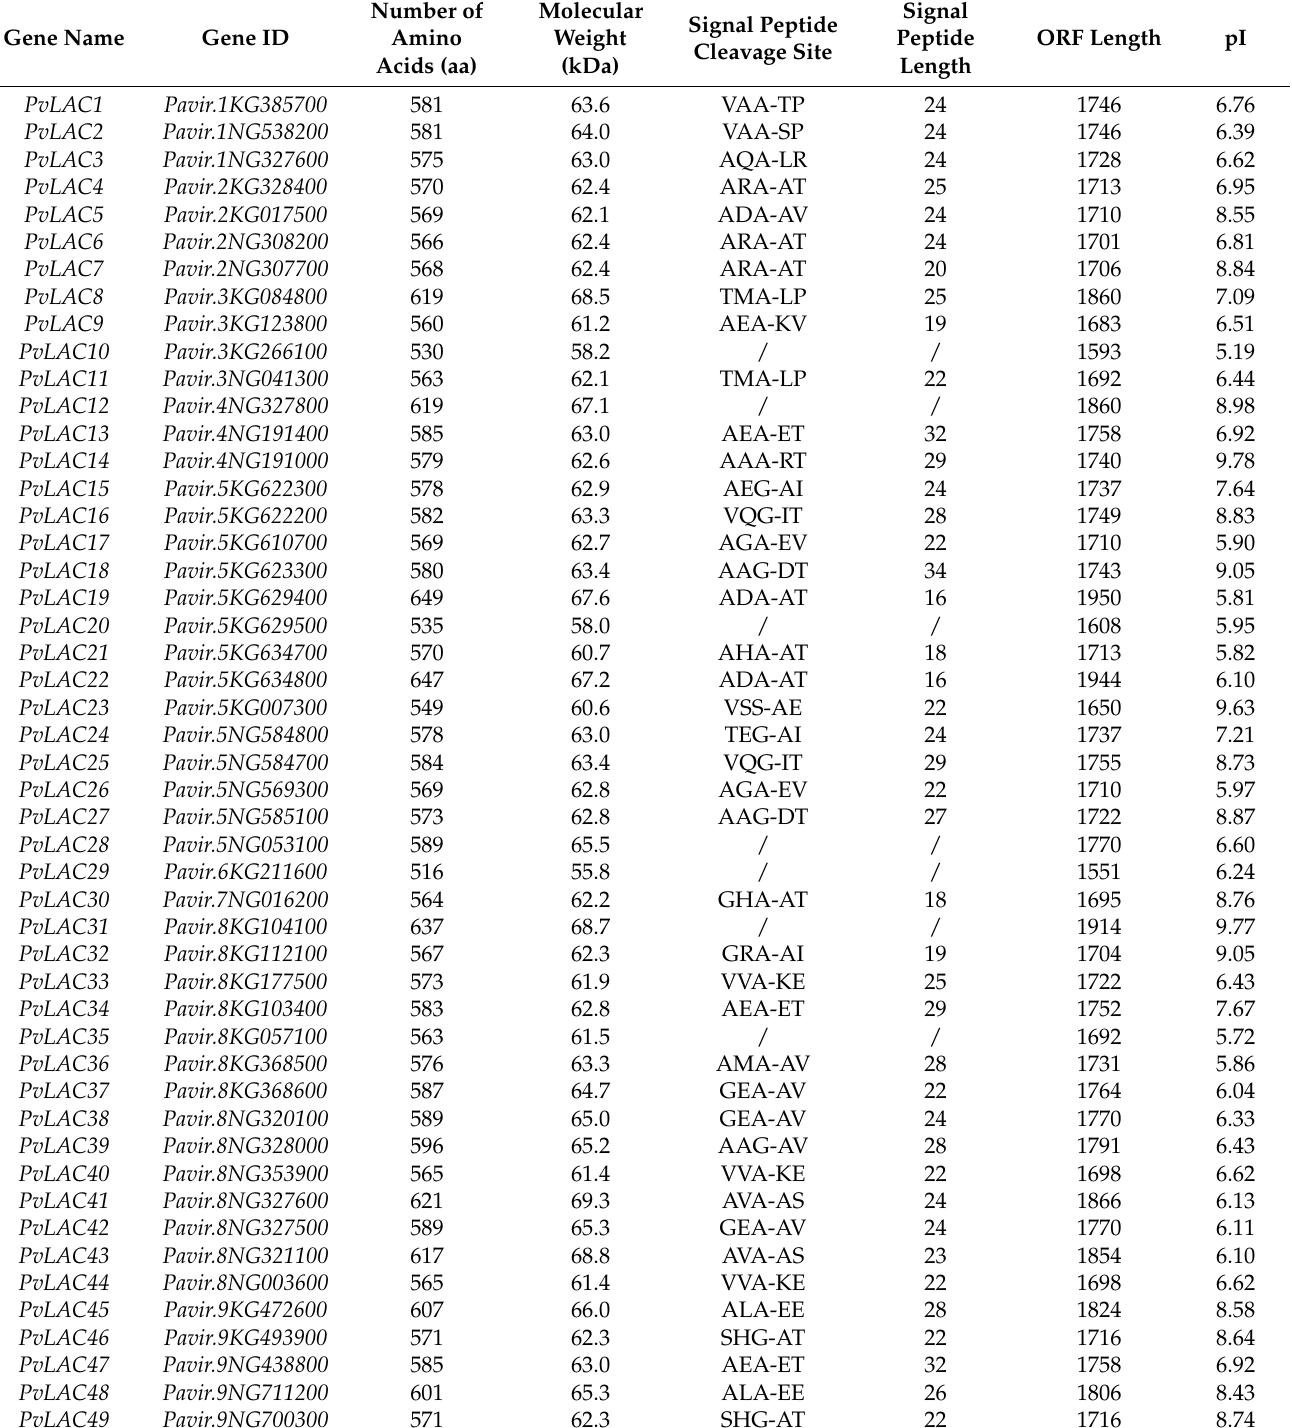
Table 1. Characterization of putative switchgrass laccase proteins. ORF, open reading frame; pI, isoelectric